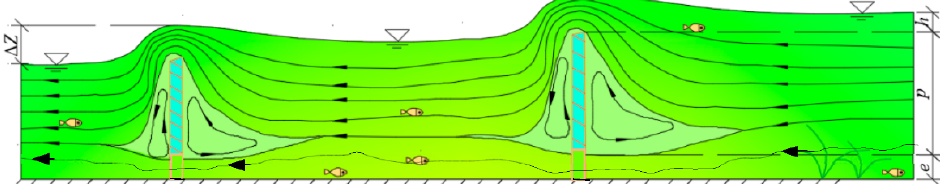
Figure 3. Flow state of the differential weir–orifice (DWO). The DWO structure forms two different flow patterns, i.e., weir flow at the top and orifice flow near the bottom, and two circular currents upstream and downstream from the weir plate. The discharge of the weir overflow and bottom orifice flow are both affected by the orifice diameter e and weir height P . The streamline is smoother than that of the two structures shown in Figures 1 and 2.